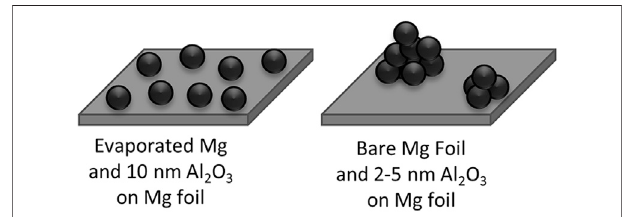
Frontiers in Energy Research |